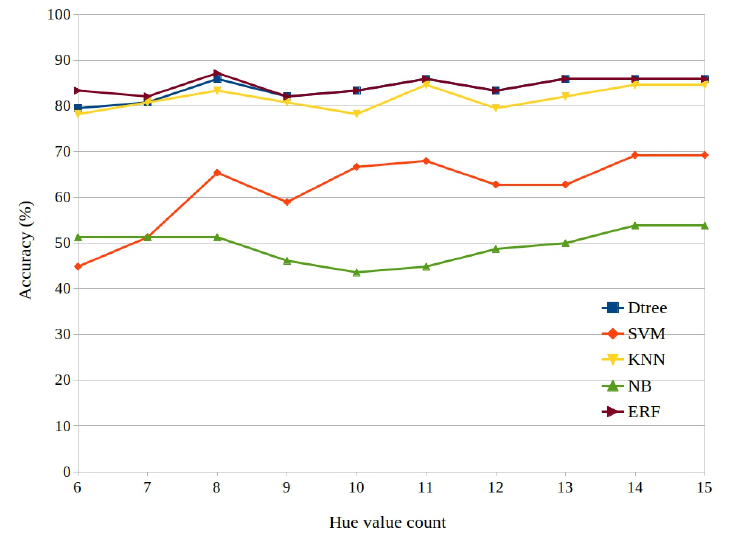
Figure 11. Accuracy without clubbing.